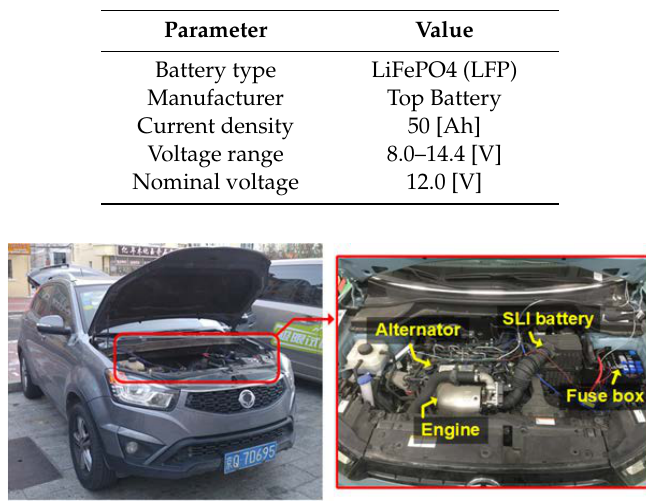
Figure 13. SLI battery used in experimental verifications: ( a ) SLI battery pack; ( b ) Internal structure and BMS board. Table 1. Specification of battery pack.